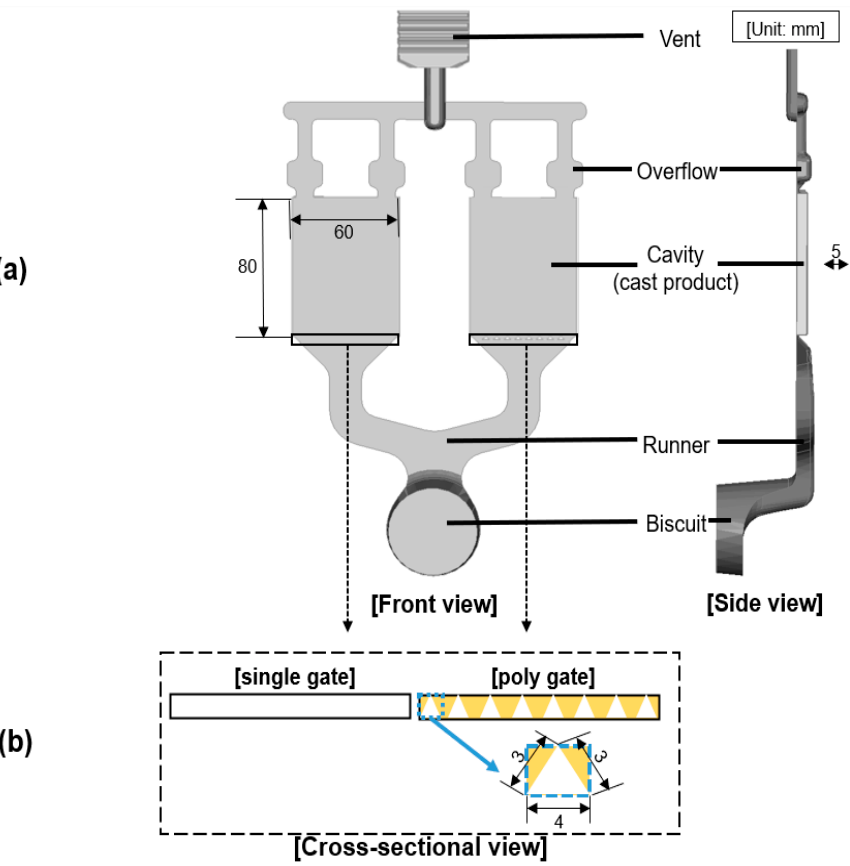
Figure 3. Schematic of casting design of mold: ( a ) front and side views of casting design and ( b ) cross-sectional view of single gate and poly gate of mold.